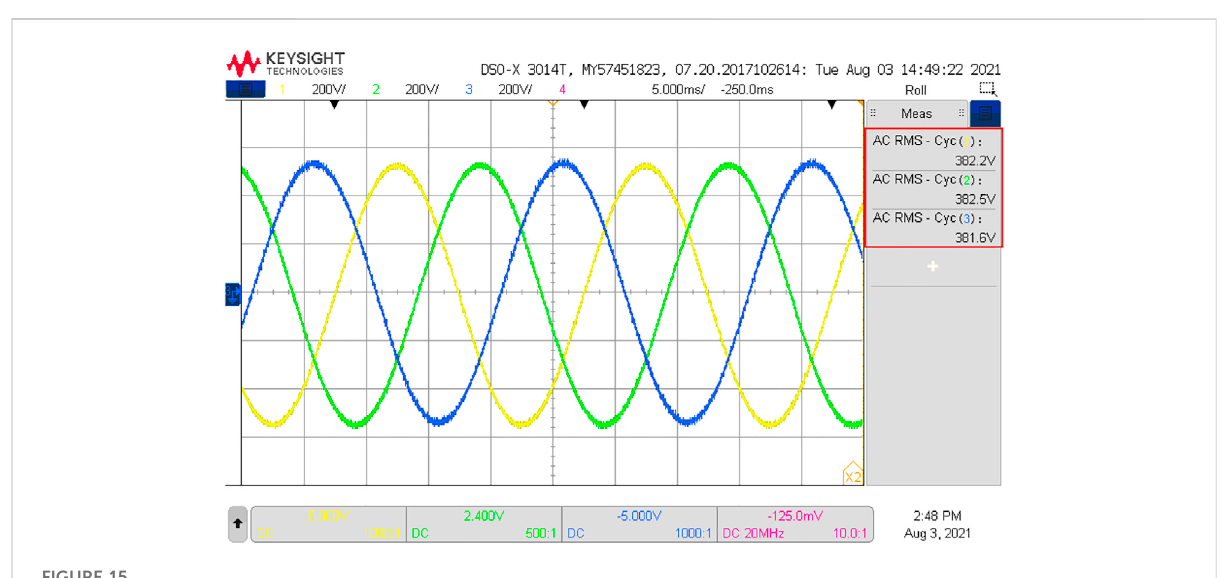
FIGURE 15 AC input voltage waveform under symmetrical grid